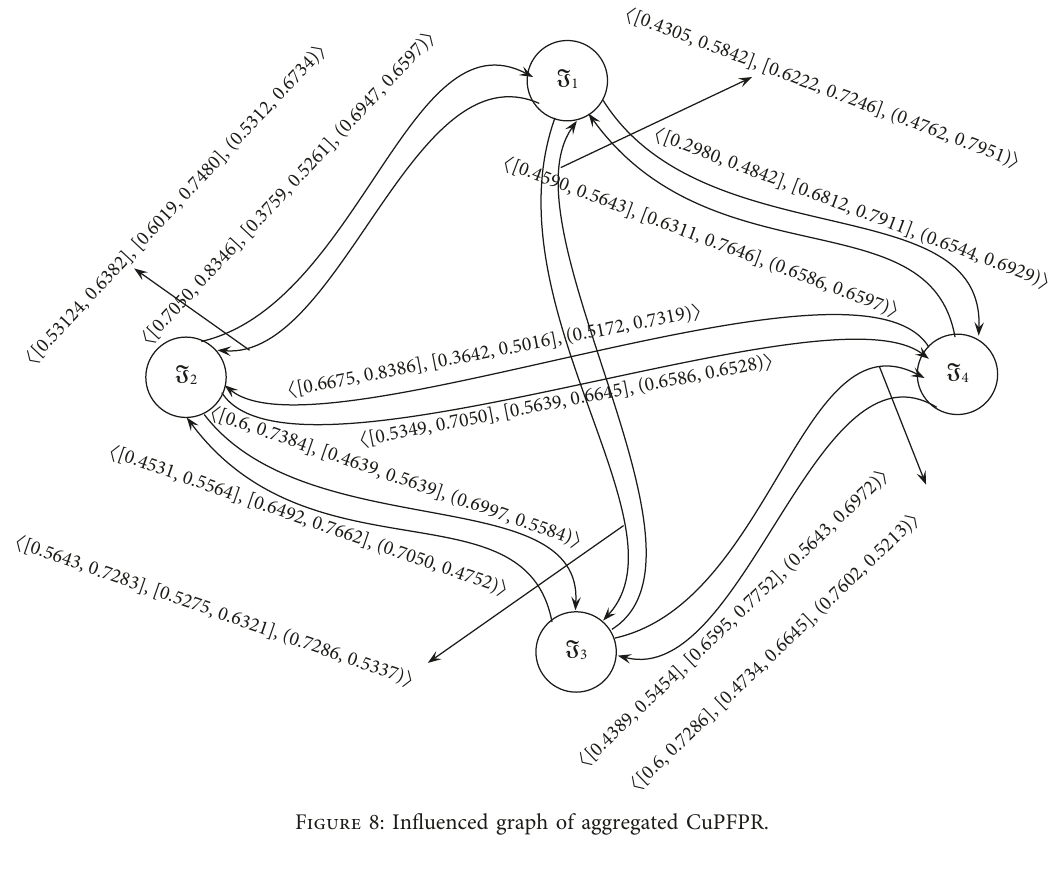
Figure 8: Influenced graph of aggregated CuPFPR.